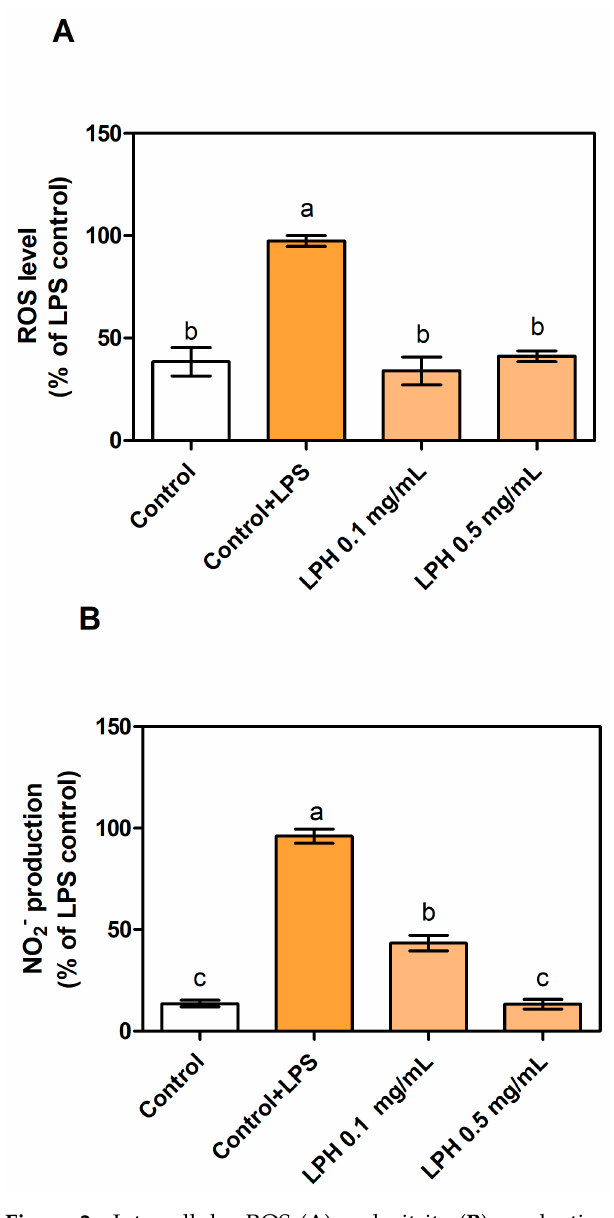
Figure 2. Intracellular ROS ( A ) and nitrite ( B ) production, expressed as percentage of fluores- cence/absorbance after 24 h incubation with or without LPS (100 ng/mL) and LPH at 0.1 and 0.5 mg/mL. Values are presented as means ± SD ( n = 3) and those marked with different letters are significantly different ( p < 0.05).